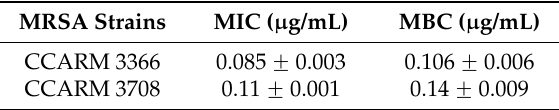
Table 1. Minimum inhibitory concentration and minimum bactericidal concentration of BV against S. aureus 3366 and